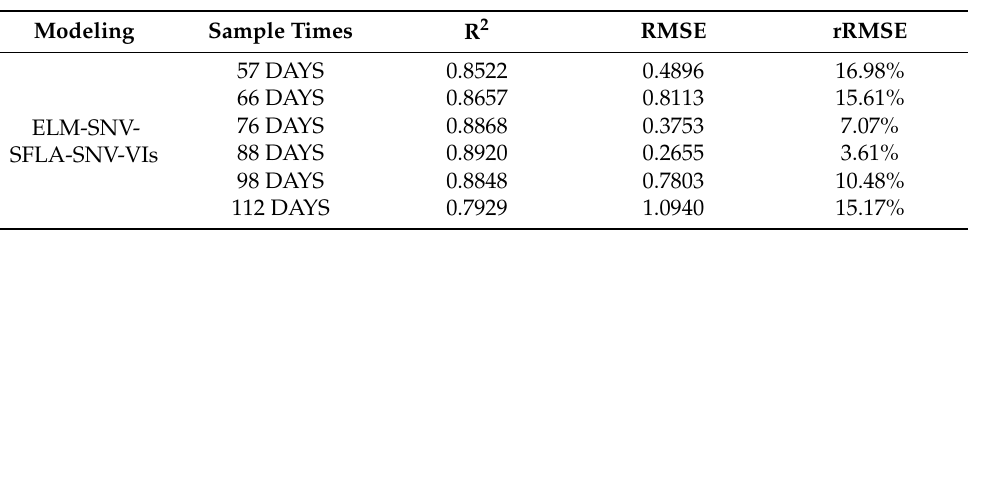
Table 9. Cotton LAI monitoring verification results of different sample times in the optimal model.